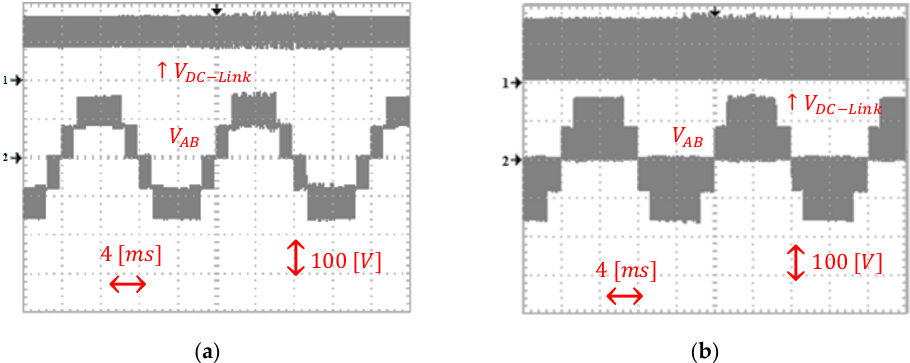
Figure 15. DC link voltage and line-to-line voltage waveforms: ( a ) SPWM method; ( b ) proposed approach.